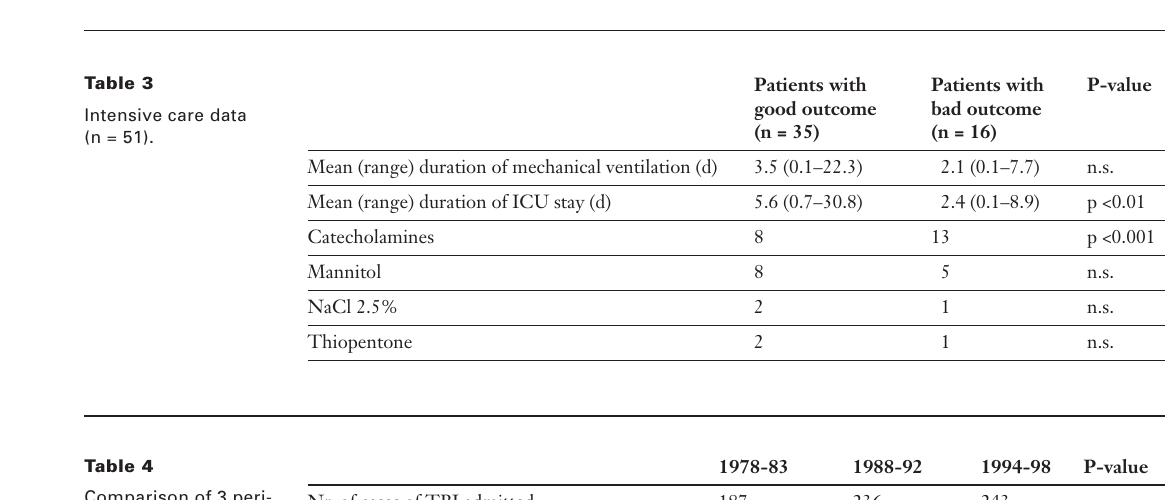
Comparison of 3 peri- ods of neurointensive